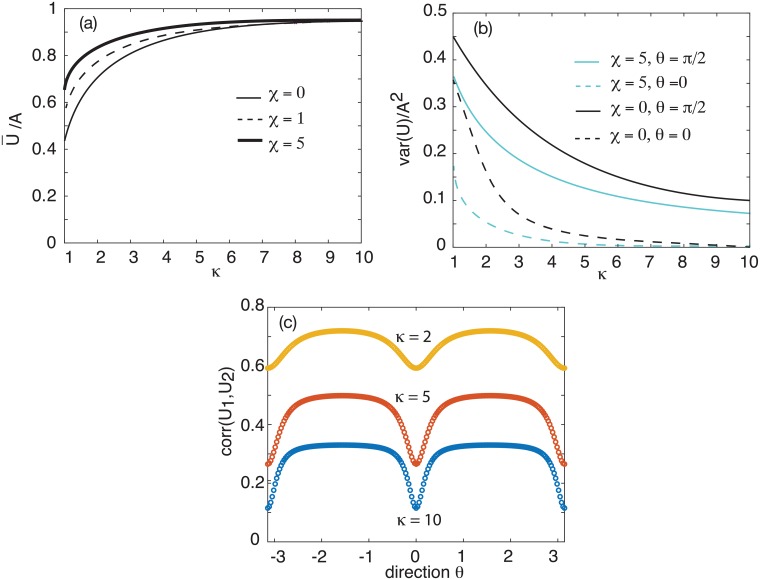
Coupled ring network (model A).(a) Amplitude of normalized mean tuning curve (36) as a function of the input parameter κ = κ1 = κ2 for various coupling strengths: χ = 0, 1, 5. (b) Corresponding maximum (θ = π/2) and minimum (θ = 0) normalized variances (37) as a function of the input parameter κ for coupling strengths χ = 0, 5. (c) Plot of correlation tuning curve (39) between cells with the same direction preference but located in different layers. Here κ = κ1 = κ2 and χ = 5.